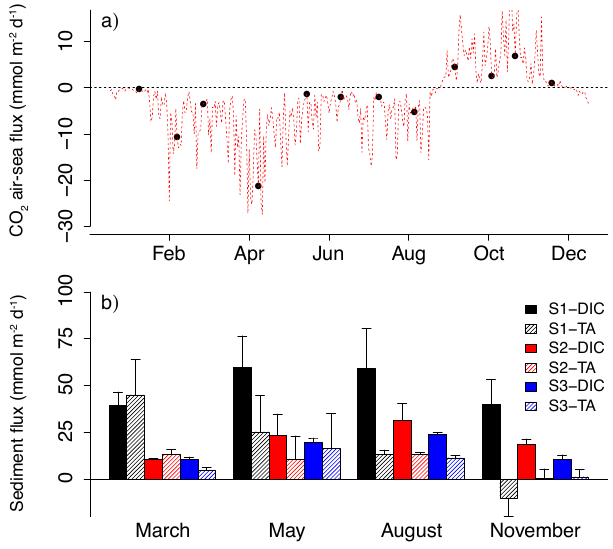
Figure 6. (a) CO 2 air–sea flux (mmol Cm − 2 d − 1 ) and (b) total sed- iment DIC and TA fluxes (mmolm − 2 d − 1 ) at three different depths (S1 = 34, S2 = 23, and S3 = 17m) in the Den Osse basin. CO 2 air- sea flux was interpolated using linear interpolation of the CO 2 sea- air gradient and daily averaged wind speed data measured at Wil- helminadorp (51.527 ◦ N, 3.884 ◦ E). Sediment fluxes were obtained from core incubations executed in triplicate (see Sect.